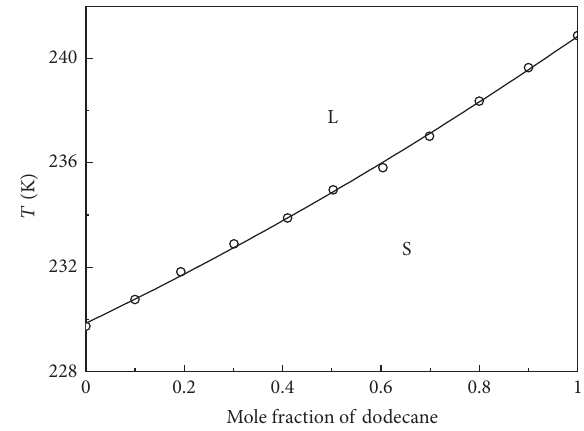
system con�ned 12